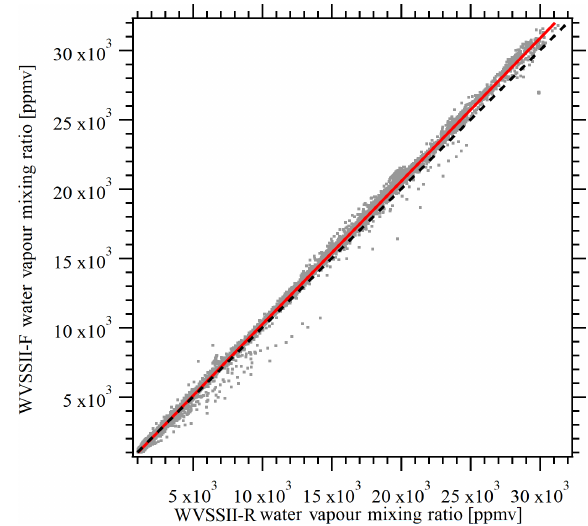
Figure 1. Comparison between WVSSII water vapour mixing ra- tio (ppmv) on the flush inlet and on the Rosemount inlet. The red line represents least squares fit to the data ( r 2 0.99), and the black dashed line is the 1:1